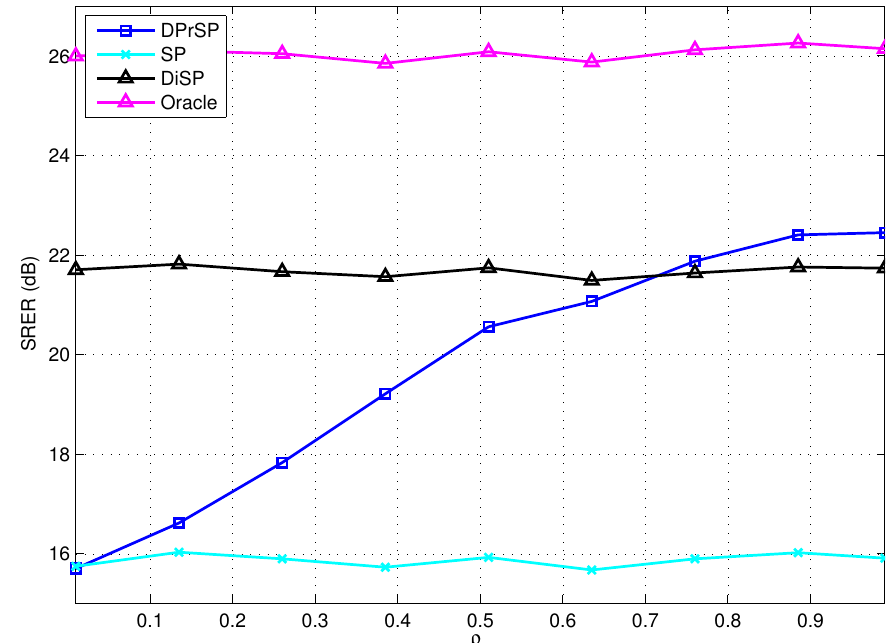
curve for DiSP and x